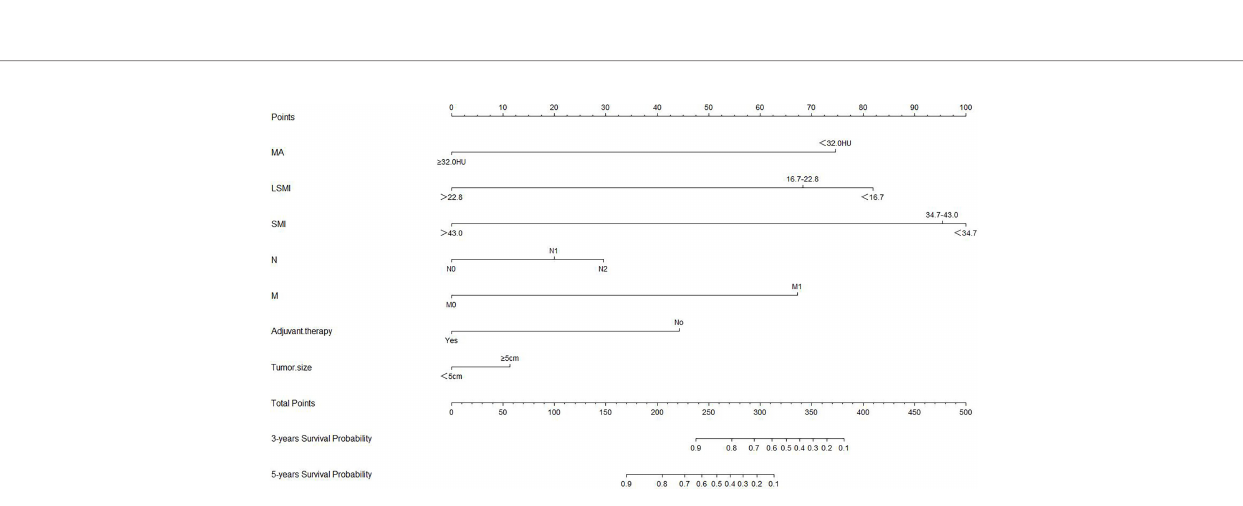
FIGURE 4 | Nomogram for predicting overall survival in colorectal cancer patients.